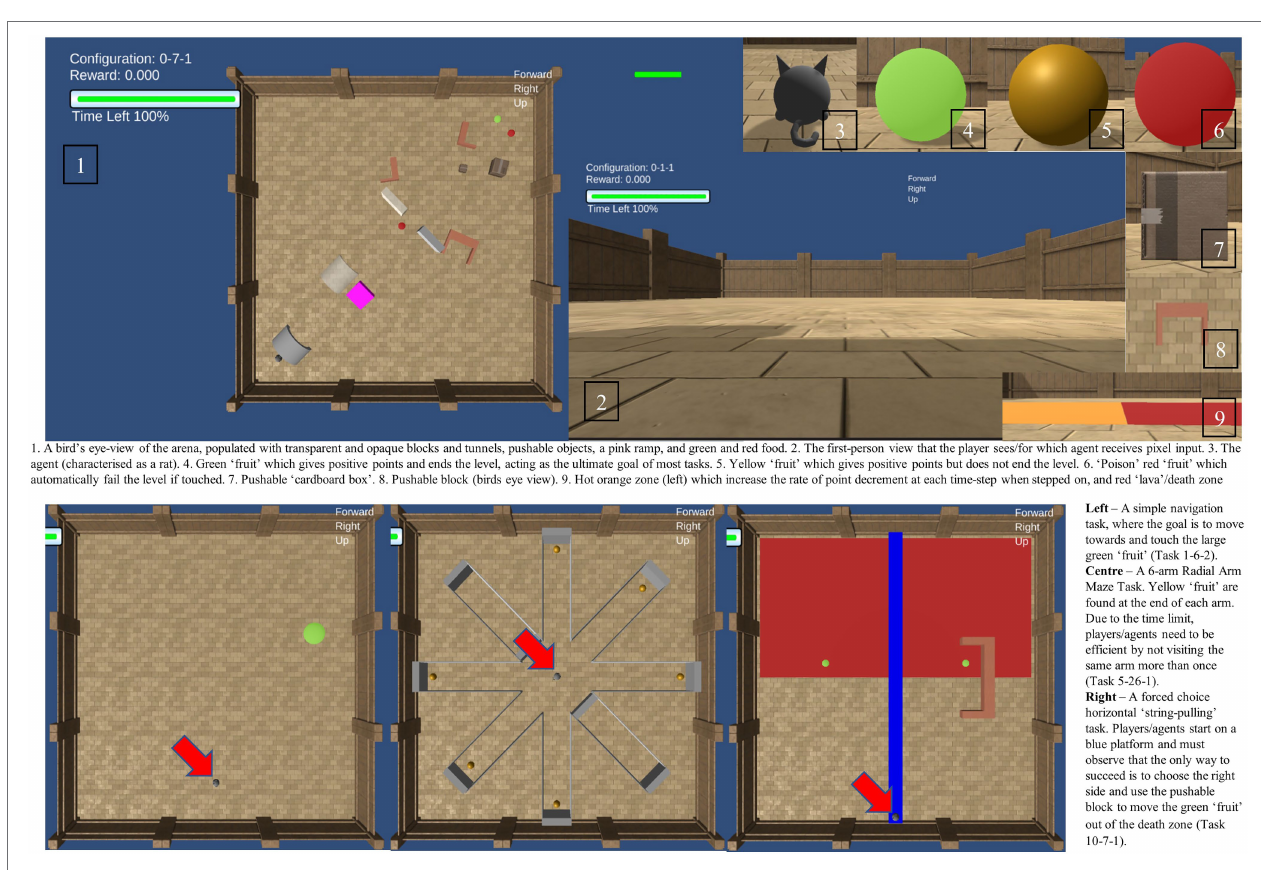
FIGURE 1 | A visual description of the Animal-AI Environment and Testbed. Full details are presented in the Supplementary Material . Images of the Animal-AI Environment and Testbed are licensed under Apache License, Version 2.0